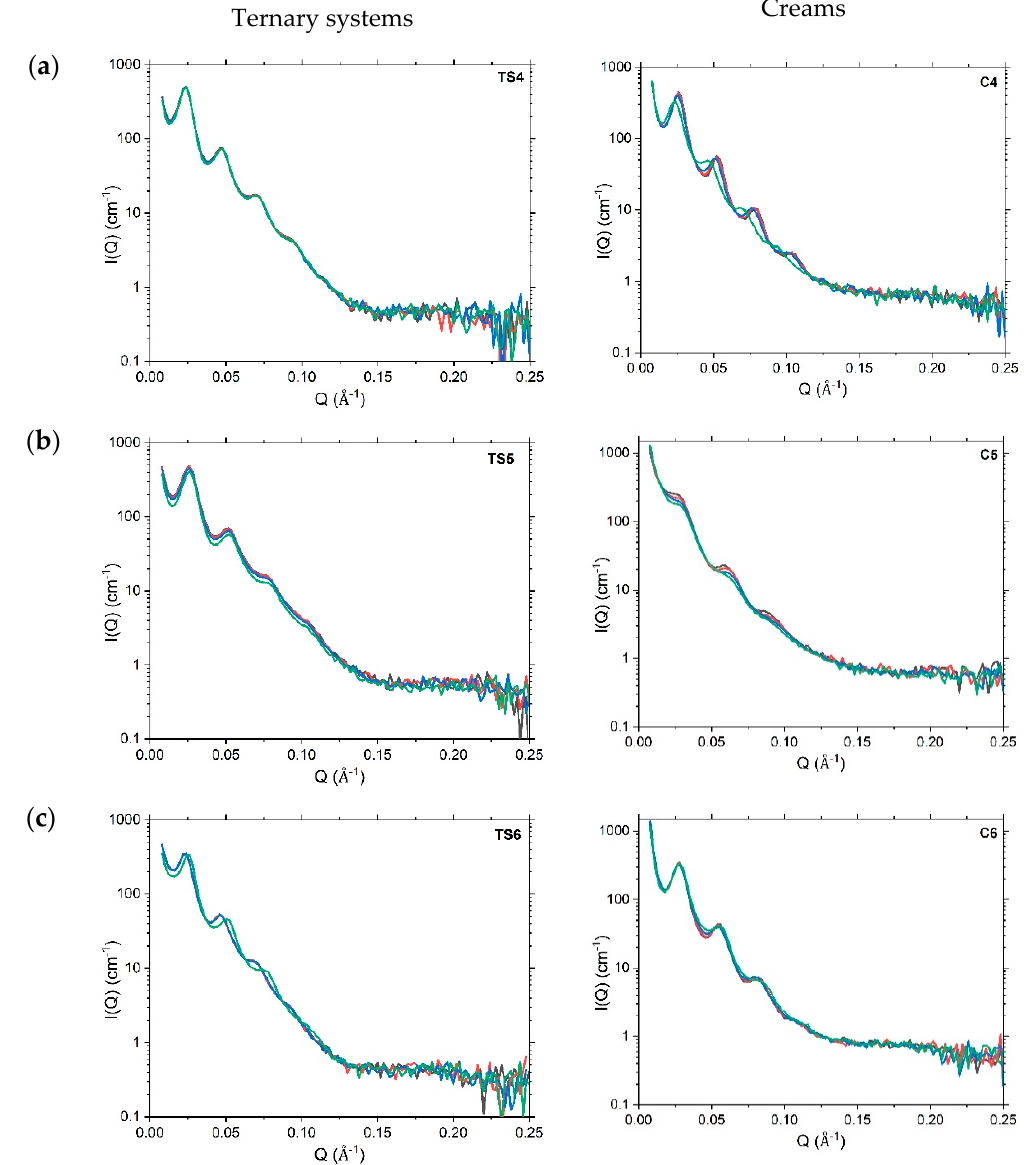
Figure 6. SANS profiles (model fits not shown) obtained at 298 (black), 305 (red), 310 (blue) and 318 (green) K ( ± 0.1 K) for 10% w / w ternary systems (left) and emulsifier creams (right) and prepared with a 1:1 ( a ), 1:0 ( b ) or 0:1 ( c ) ratio of hexadecanol:octadecanol co-surfactants. Error bars on the measured data are subsumed within the plotted symbols. Formulation compositions are provided in Methods,